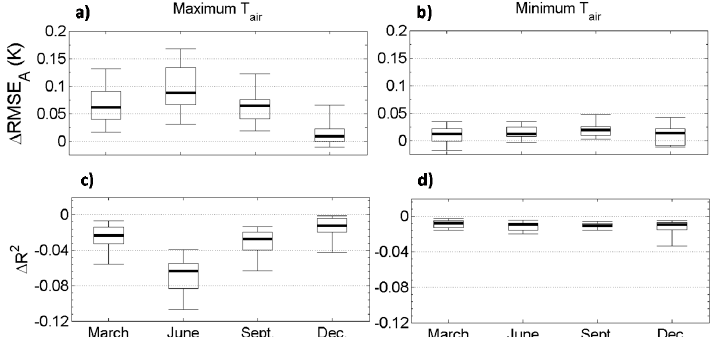
Figure 6. Temporal variation of the difference between the RMSE A and the R 2 of maximum ( a , c